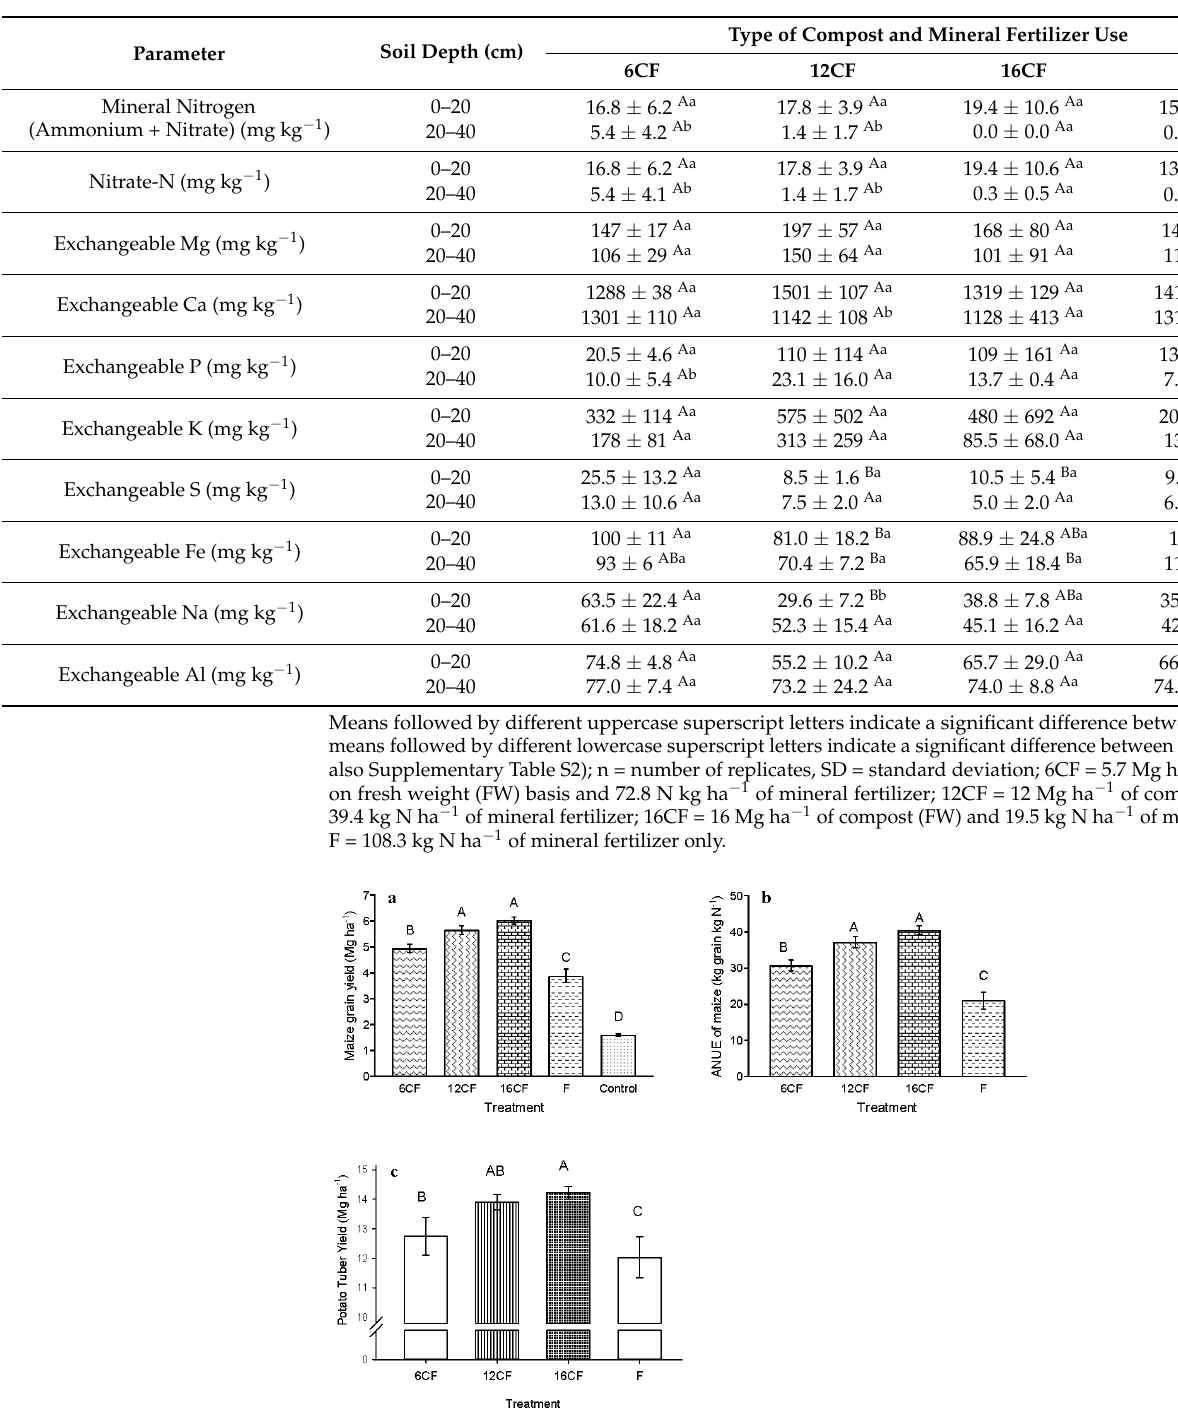
Table 3. Soil exchangeable nutrient contents and C/N ratio for the different compost and mineral fertilizer treatments in 0–20 cm and 20–40 cm soil depths (n = 4, mean ± SD).